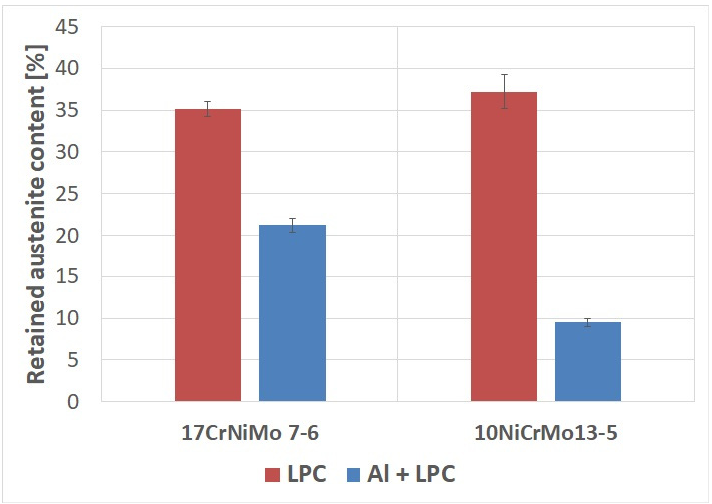
Figure 7. Retained austenite content in 17CrNiMo 7-6 and 10NiCrMo13-5 steels .